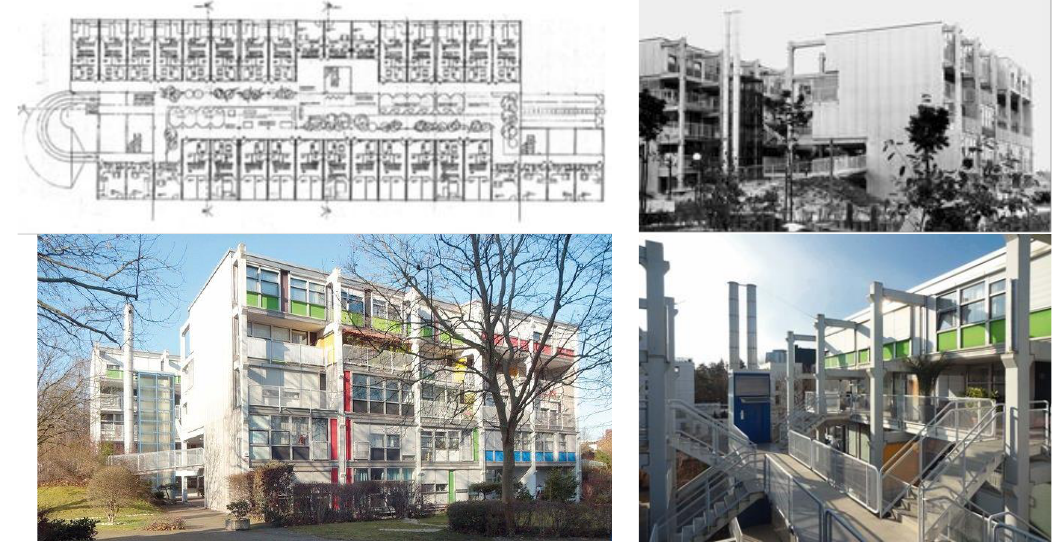
Figure 4 Supports and infills, ‘Elementa’, O. Steidle & Partners, 1972,